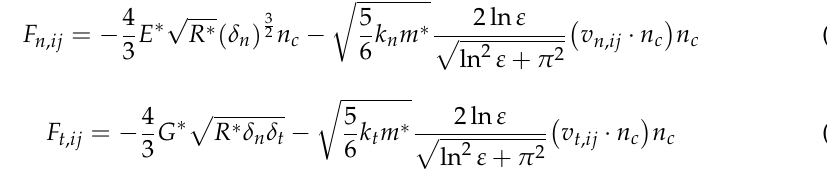
where, E ∗ is the equivalent elastic modulus, Pa; R ∗ is the equivalent radius, m; m ∗ is the equivalent mass, kg; G ∗ is the equivalent shear modulus, Pa; δ n is the normal overlap; δ t is the tangential overlap; k n is the normal stiffness; k t is the tangential stiffness; n c is the unit vector connecting the centers of two particles; ε is the elastic recovery coefficient; v n , ij is the relative normal velocity of particle j, m/s, and v t , ij is the relative tangential velocity of particle i to particle j ,